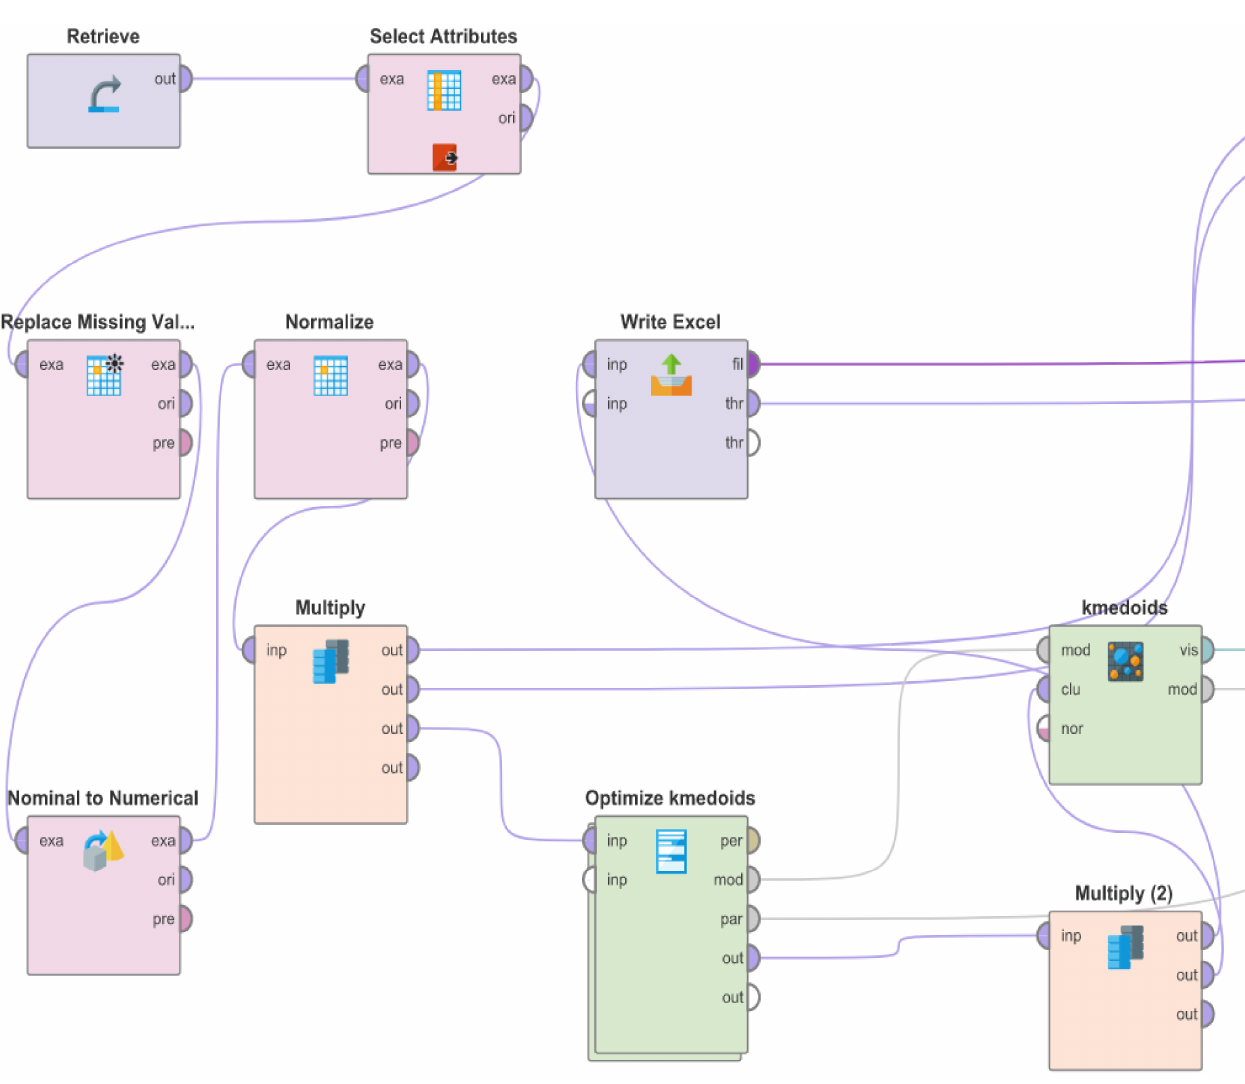
Figure 1. The process of the clusters’ calculation was performed in RapidMiner. The file is attached in the Supplementary Materials. Table 2. Characteristics of patients in each cluster and the whole group. The lowest values are marked green and the highest ones are